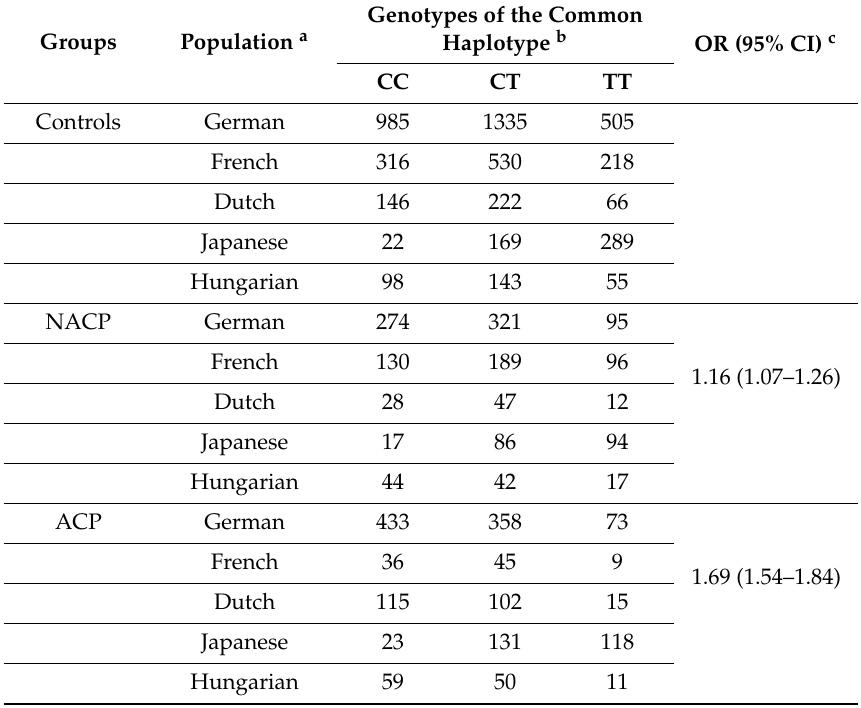
Table6. Testof gene-environment interactionbetweenthe common PRSS1-PRSS2 haplotypeand alcohol consumption using a multinomial logistic regression